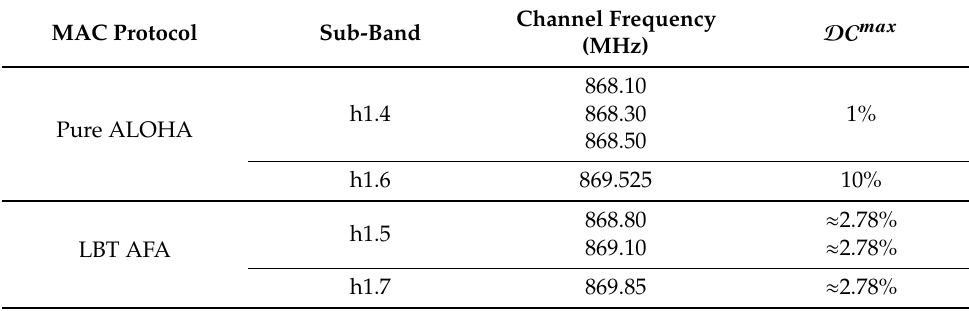
Table 4. SPC scenario—Configuration A.